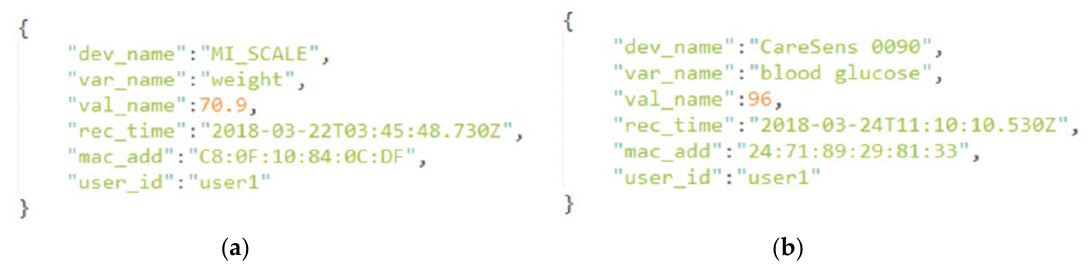
Figure 3. An example of user weight ( a ) and user blood glucose (BG) ( b ) sensor data in the NoSQL MongoDB.